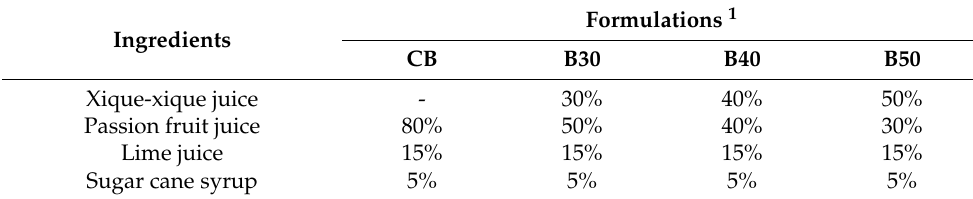
Table 1. Formulation of beverages with xique-xique cladode, passion fruit and lime juices and sugar cane